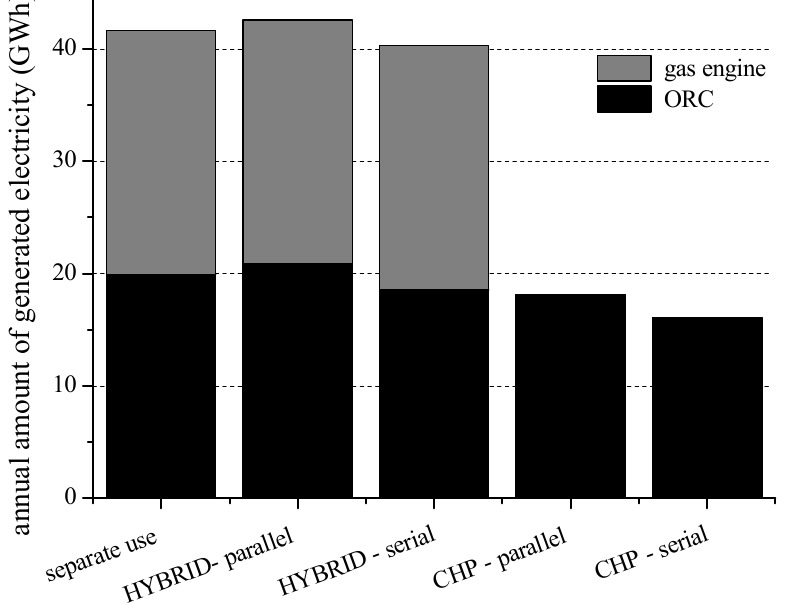
Figure 6. Annual amount of generated electricity for the investigated power plant concepts.